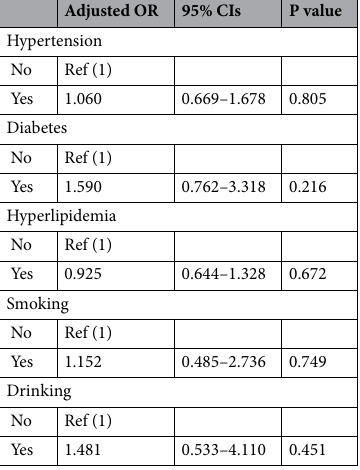
Table 5. Multivariate logistic regression analysis of possible risk factors for